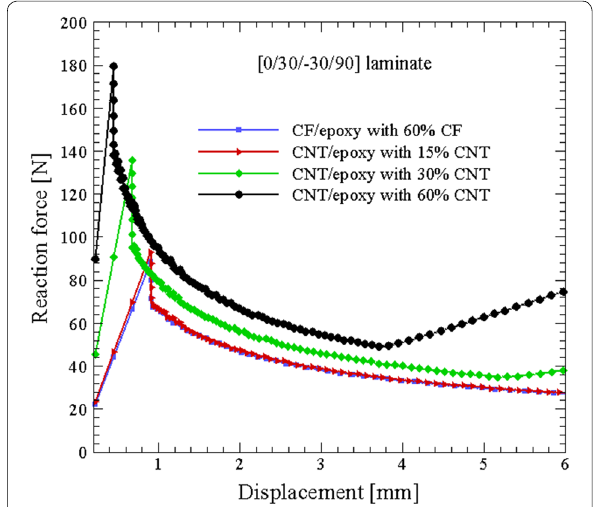
Fig. 12 Variation of reaction force with displacement at different fibre volume fractions for [0/30/–30/90] stacking sequence of